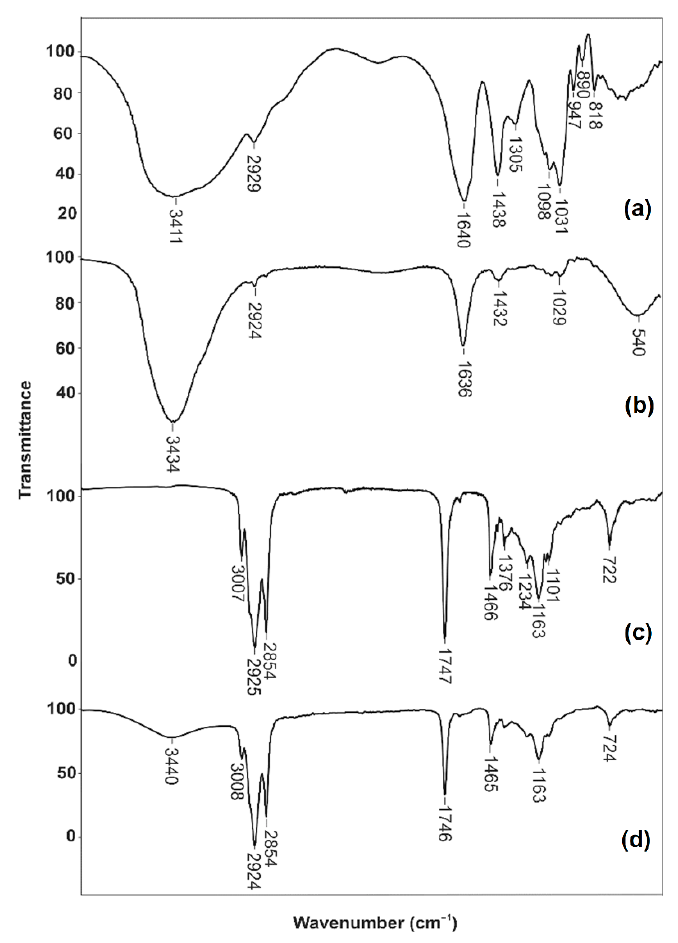
Figure 5. FTIR spectra of sodium alginate powder ( a ), Ca-alginate beads ( b ), oil enriched with ca- rotenoids from orange peel ( c ), and oil-loaded Ca-alginate beads ( d ).